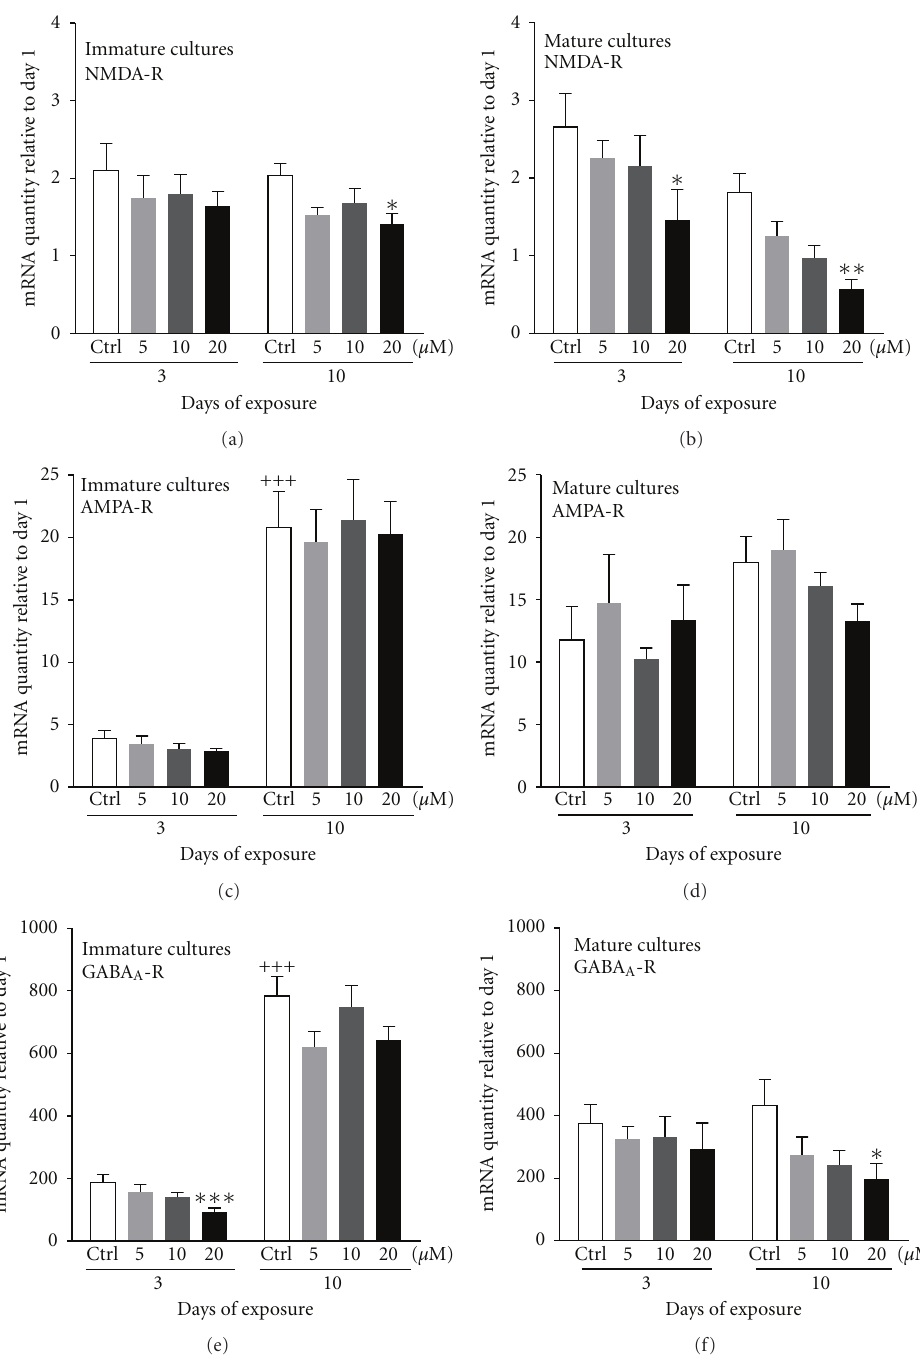
Figure 2: Changes in the mRNA levels of neural receptors in primary cultures of CGCs exposed to domoic acid (5 μ M, 10 μ M, and 20 μ M), at 1 DIV (immature cultures) or at 7 DIV (mature cultures) for 3 or 10 days. Note the significant downregulation of (a) NMDA-R in immature cultures after 10 days of exposure (20 μ M), (b) NMDA-R in mature cultures, (e) GABA A -R in immature cultures after 3 days of exposure (20 μ M), and (f) GABA A -R in mature cultures after 10 days of exposure (20 μ M). There were no changes for (c) AMPA-R in immature cultures and (d) AMPA-R in mature cultures. Gene expression levels were normalized to the standard calibrator, the housekeeping gene 18S rRNA and the mRNA expression at 1 DIV. Data represent mean ± S.E.M. of three independent experiments performed in duplicates. + P < 0 . 05 ++ P < 0 . 01 +++ P < 0 . 001 comparing control cultures at 3 and 10 days. ∗ P < 0 . 05 ∗∗ P < 0 . 01 ∗∗∗ P < 0 . 001 comparing treated to control (untreated)